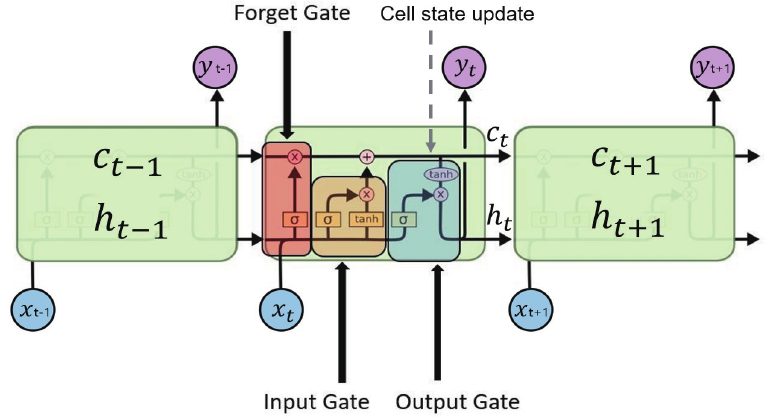
Figure 8. Long Short Term Memory